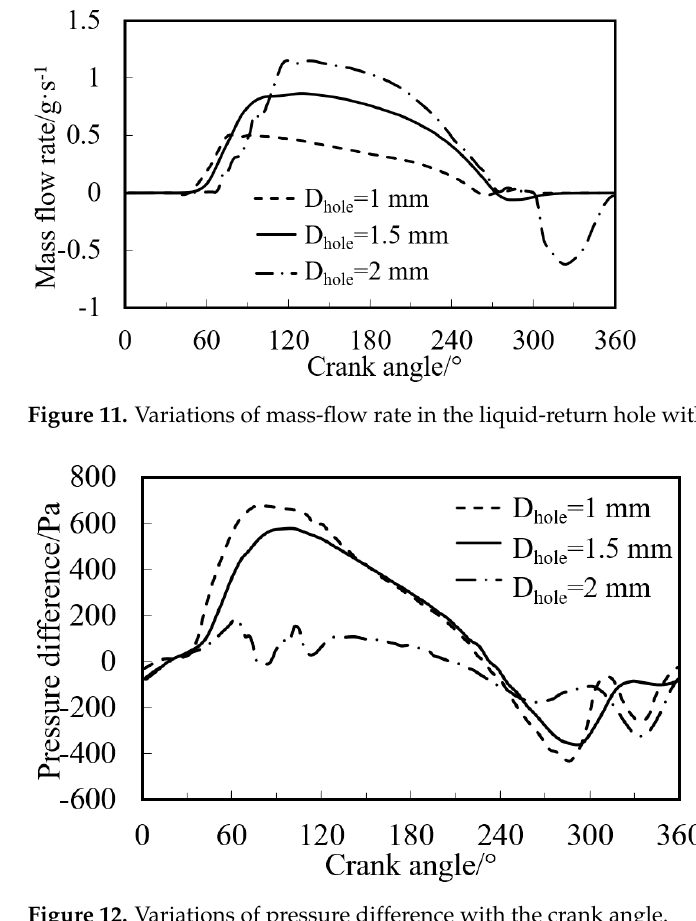
Figure 13. Variations of liquid velocity in the liquid-return hole with the crank angle.